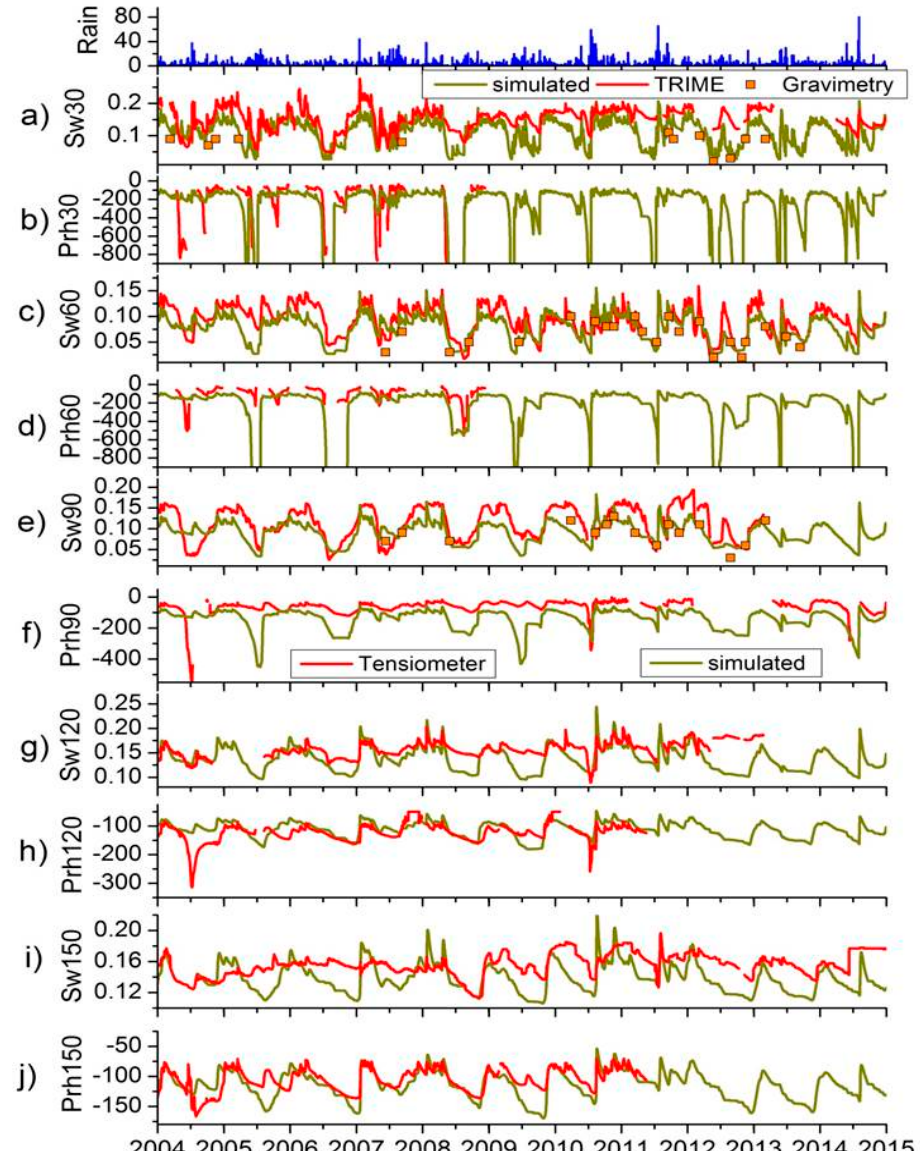
Figure 8. Daily rainfall (Rain) in mm d − 1 , simulated and measured soil water contents (TRIME, Gravimetry) in cm 3 cm − 3 at soil compartments 0–30 cm ( a , Sw30), 30–60 cm ( c , Sw60), 60–90 cm ( e ,